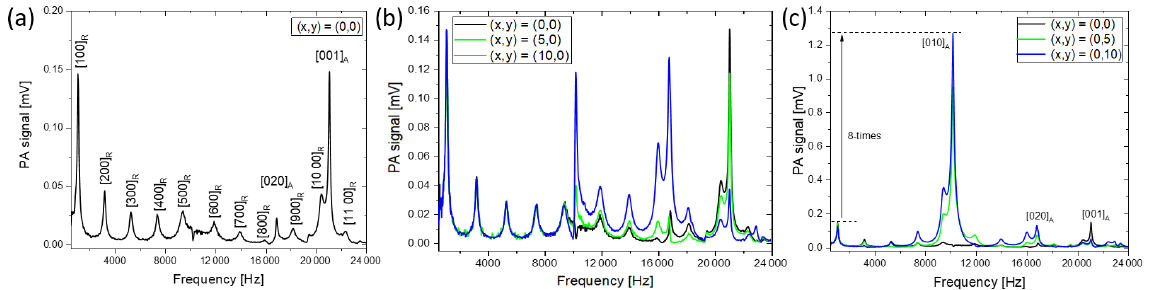
Figure 2. Frequency spectra of cell number 4 at a methane concentration of 100ppm and a flow of 300mLmin − 1 at different laser beam positions. (a) ( x,y ) = (0,0), (b) ( x,y ) = (0,0), (5,0), and (10,0), and (c) ( x,y ) = (0,0), (0,5), and (0,10); lkr denotes the longitudinal, azimuthal, and radial modes; and the subscripts A and R denote the absorption and resonance